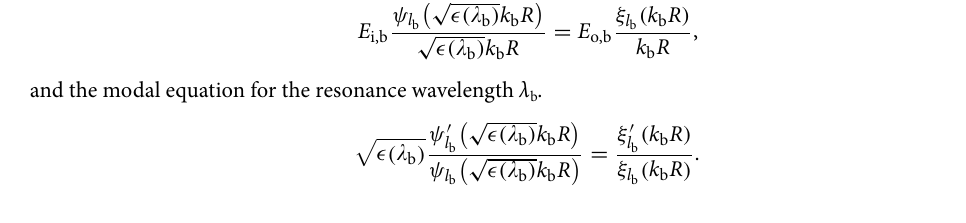
392.58 nm and red-detuned = S P S ≡ − transition with | � | � | �